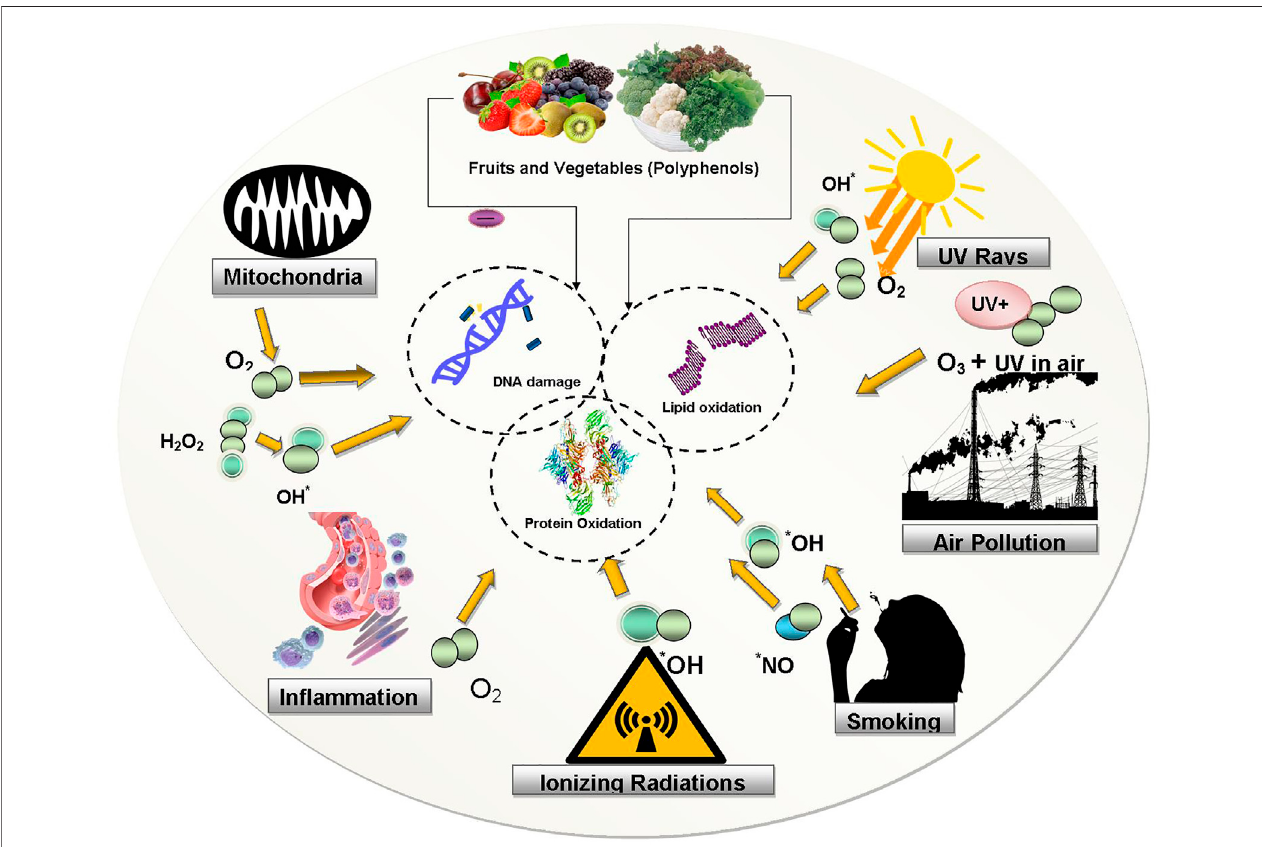
FIGURE 1 | Deleterious effects of OS/ROS on biomolecules. ROS generated from various sources (environmental/biological) cause oxidations of lipid, protein and DNA molecules. Abbreviations: UV: ultraviolet rays, OH: hydroxyl, NO: nitrogen oxide, O2: oxygen, O3: Ozone, H2O2: hydrogen peroxide.